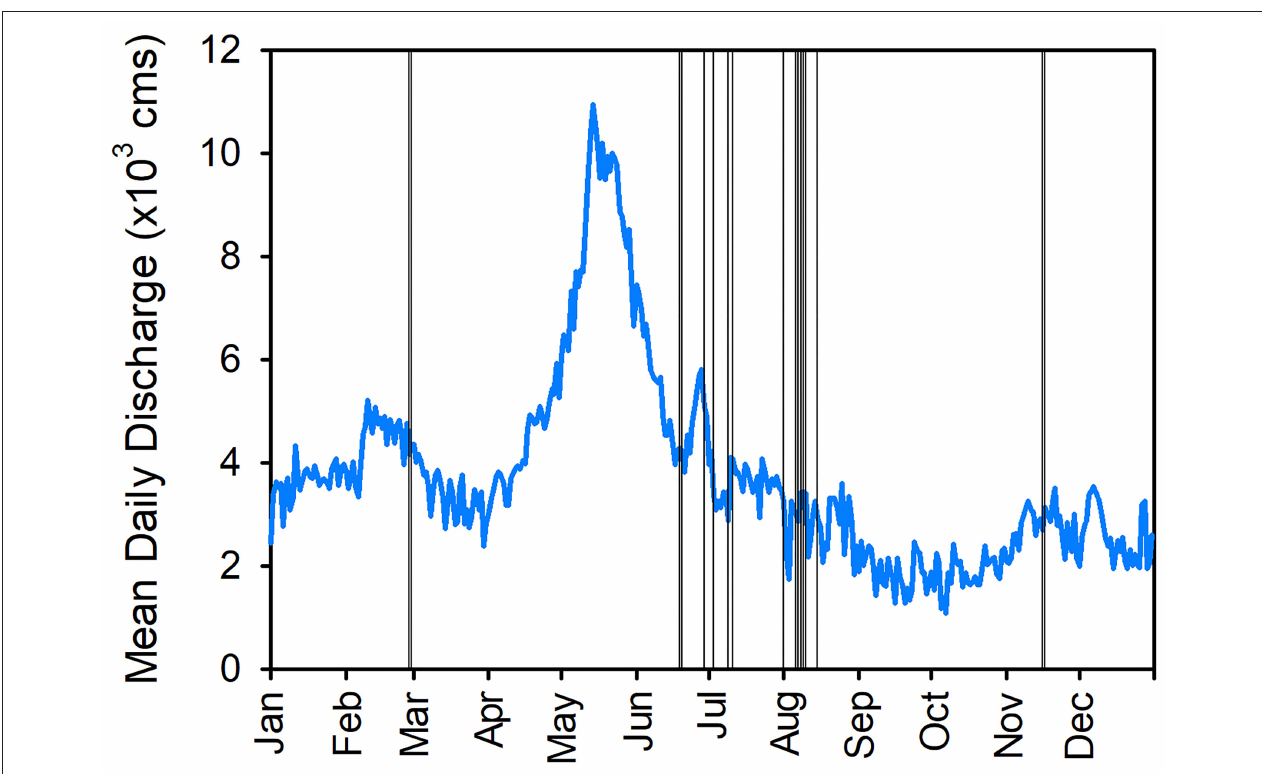
FIGURE 2 | Mean daily discharge on the Columbia River for calendar year 2018, as observed at the Priest Rapids gage (USGS 12472800). Vertical lines indicate days of field data collection along the Hanford